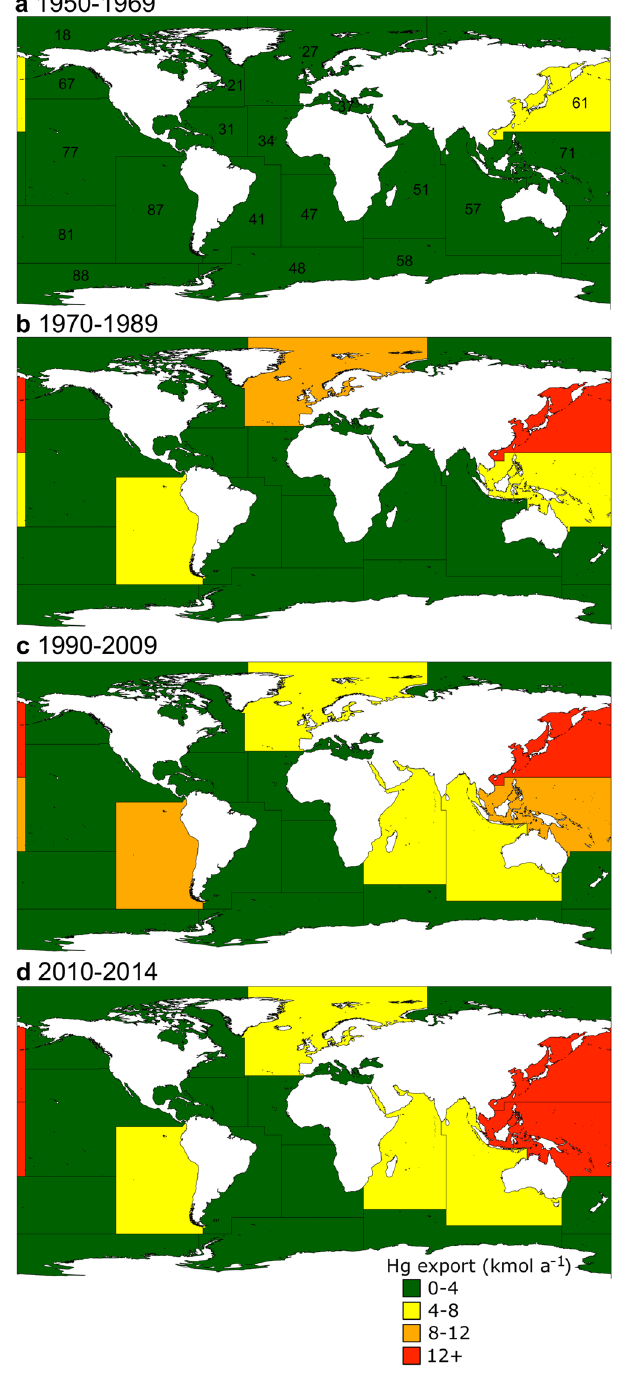
Figure 2. Mercury export from the ocean. Mean total Hg export in ( a ) 1950–1969, ( b ) 1970–1989, ( c ) 1990– 2009, and ( d ) 2010–2014 resulting from catches of fishes, molluscs, crustaceans, reptiles, and mammals for each MFA (numbers are provided in panel (a) and corresponding names are found in Supplementary Table 7). Standard deviations of means for each period are found in Supplementary Fig. 4. Maps were created in ArcGIS version 10.3.1